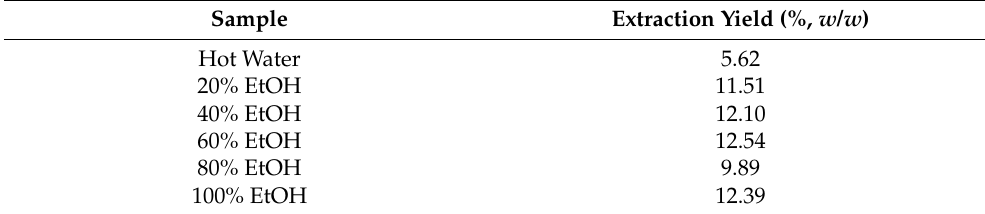
Table 1. Extraction yields of Camellia japonica